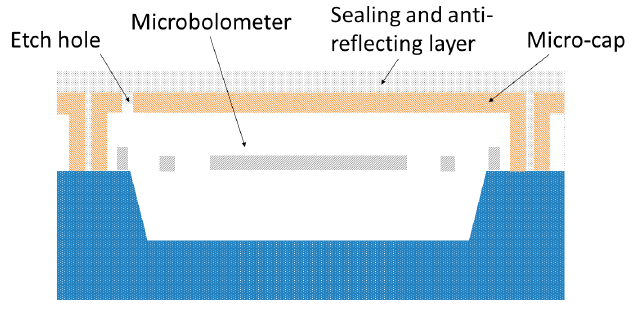
Figure 10. Schematics of the pixel level packaging technology.